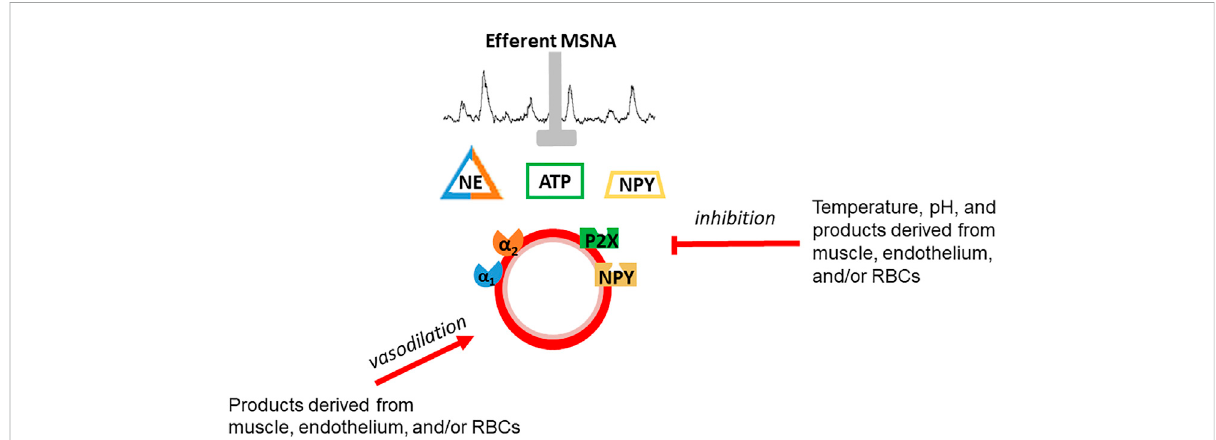
Schematic depiction of functional sympatholysis which is postulated to be due to inhibition of sympathetic vasoconstriction of by vasoactive molecules released from skeletal muscle, the vascular endothelium, or red blood cells. Temperature and pH also contribute. This phenomenon is distinct from vasodilation although some of the same substances are thought to be involved in vasodilation and